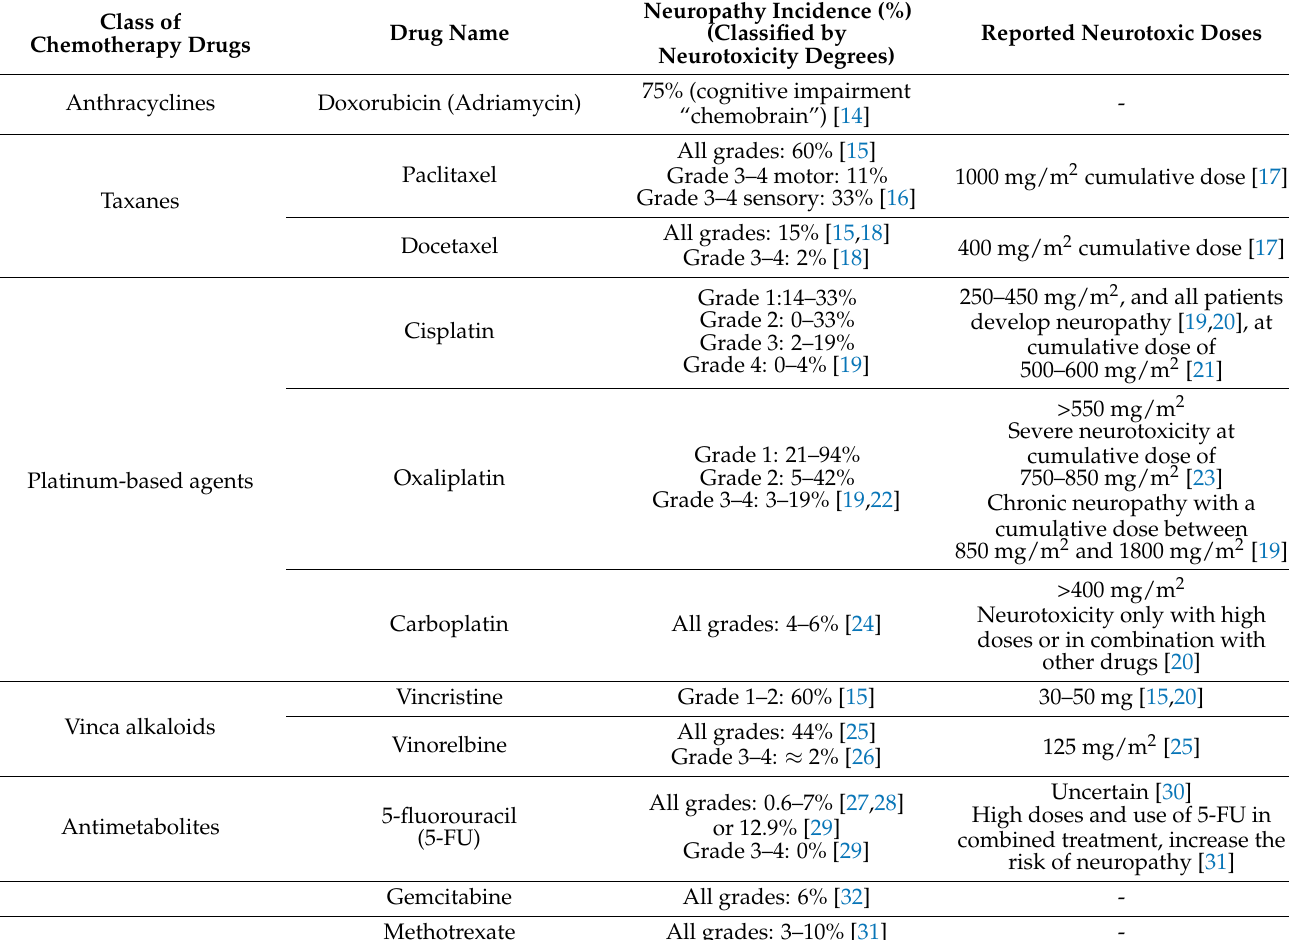
Table 1. Incidence of neuropathy induced by main classes of cancer chemotherapy